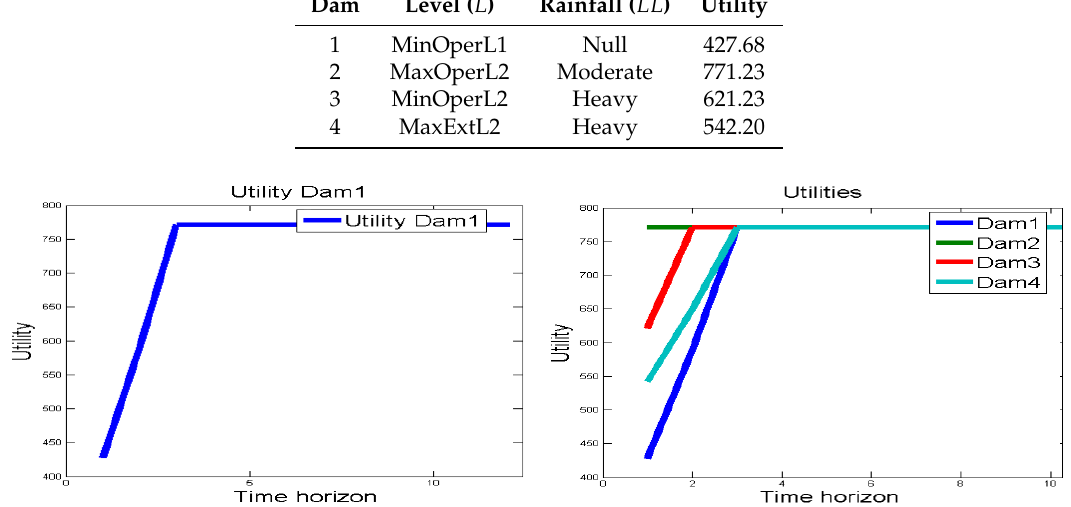
Figure 5. ( left ) Utility values for a one-dam system. ( right ) Utility values for a four-dam